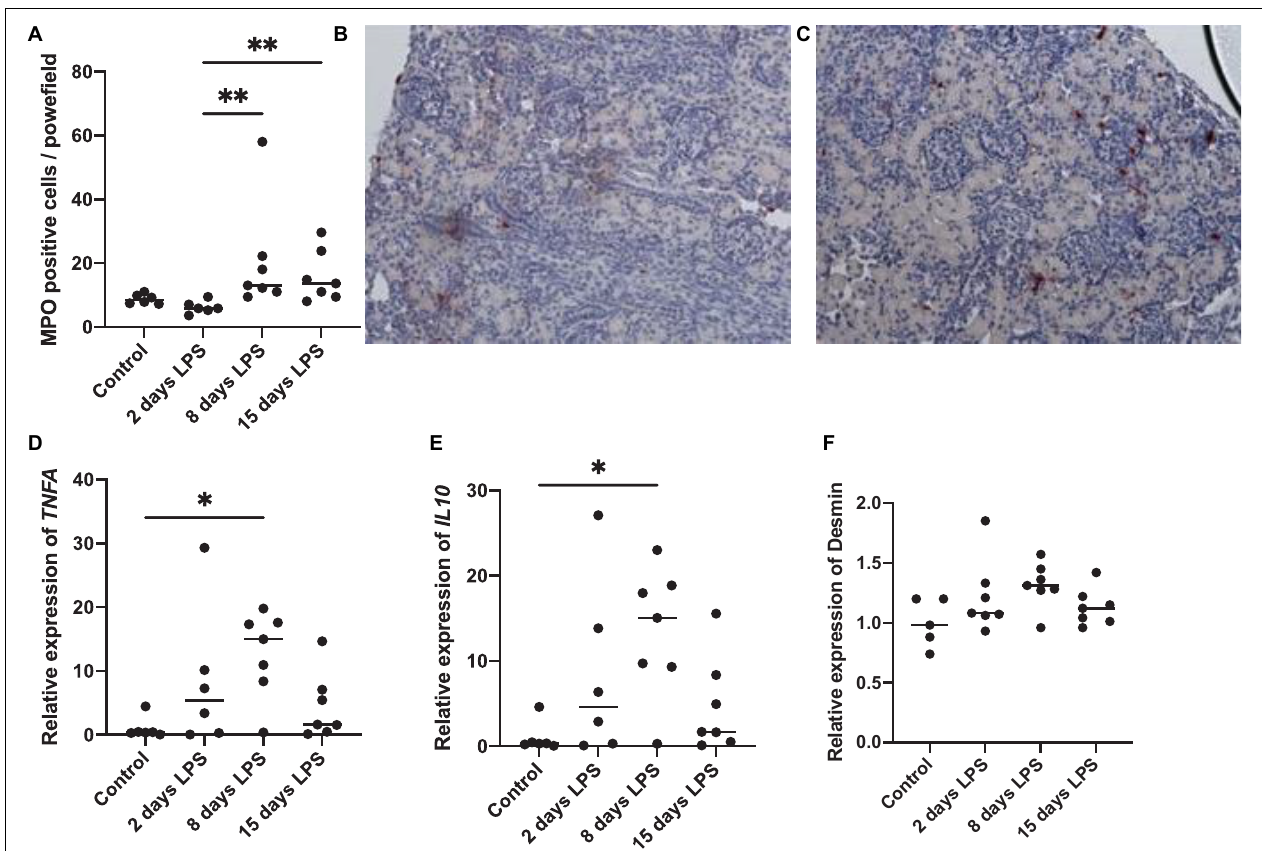
FIGURE 2 | Inflammatory and injury markers in kidney tissue. Each point represents an individual animal, horizontal line marks the median. Data were analyzed using Kruskal–Wallis test and post hoc Dunn’s test. (A) Average number of myeloperoxidase (MPO) positive nuclei per power field at 200 × magnification, ∗∗ p < 0.01 compared with 2 days lipopolysaccharide (LPS); (B) Representative image of MPO staining in control; (C) Representative image of MPO staining at 15 days LPS; (D) qPCR relative expression of tumor necrosis factor alfa ( TNFA ), ∗ p < 0.05 compared to control; (E) qPCR relative expression of IL10 , ∗ p < 0.05 compared with control; (F) qPCR relative expression of